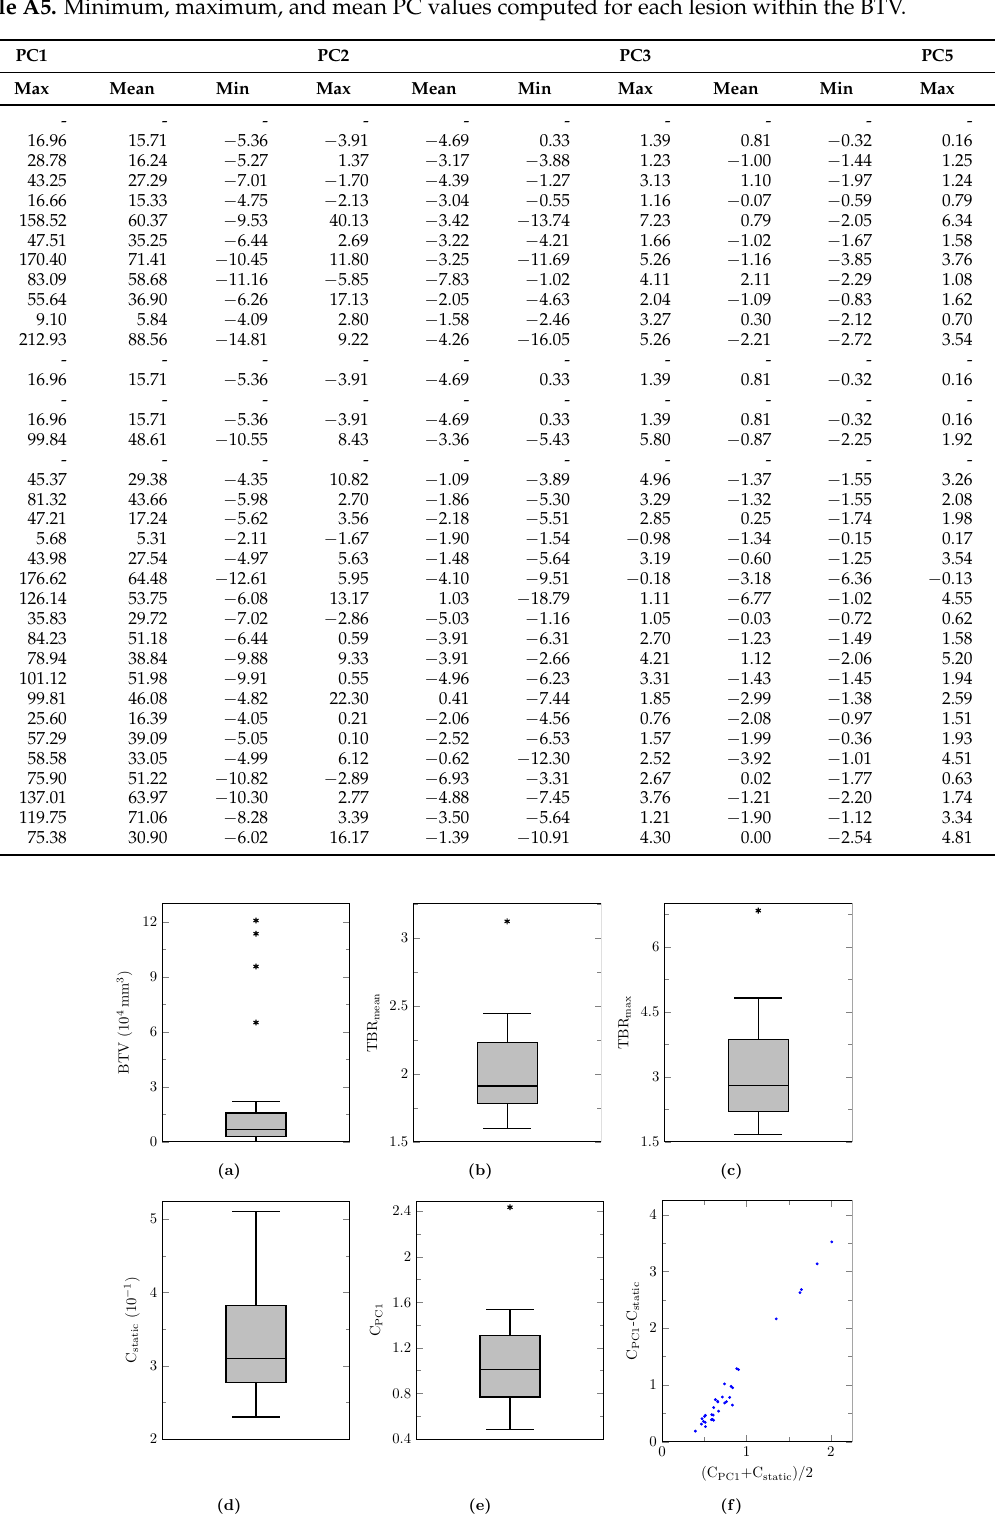
Figure A3. Distribution of the PET parameters in Table A3 for lesions with a non-zero BTV summa- rized by means of boxplots (horizontal line: median, box: interquartile range, whiskers: ± 1.5 in- terquartile range, *: outliers) ( a – e ) and Bland-Altman plot of C PC1 versus C static ( f